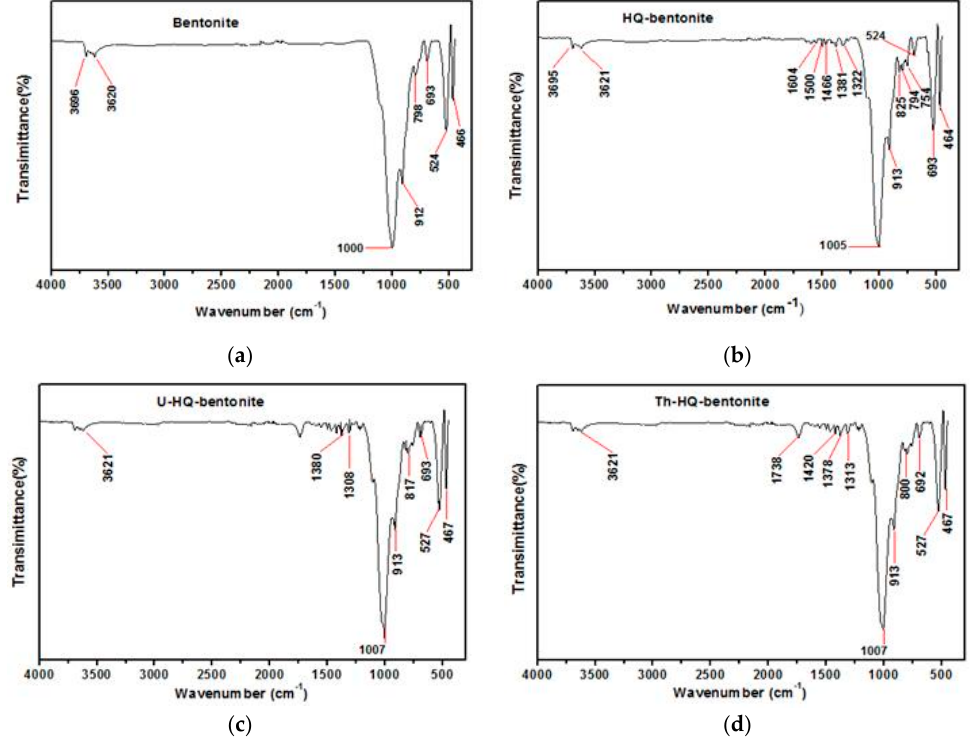
Figure 5. Fourier Transform Infrared (FT-IR) spectra of ( a ) Na-bentonite, ( b ) HQ-bentonite, ( c ) U(VI) ions loaded HQ-bentonite, and ( d ) Th(IV) ions loaded HQ-bentonite.